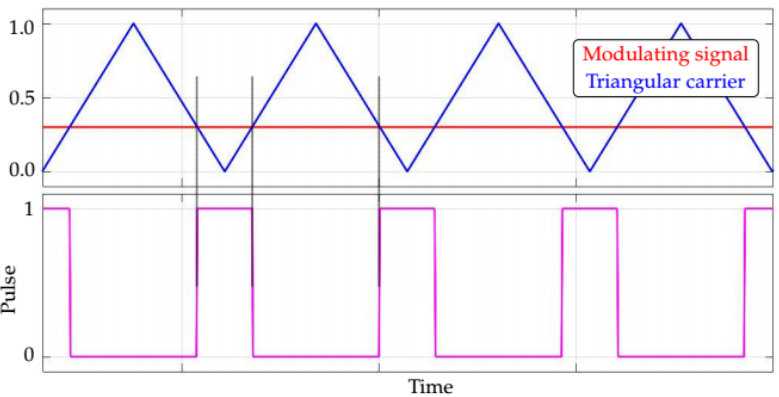
Figure 6. Basic PWM pulse